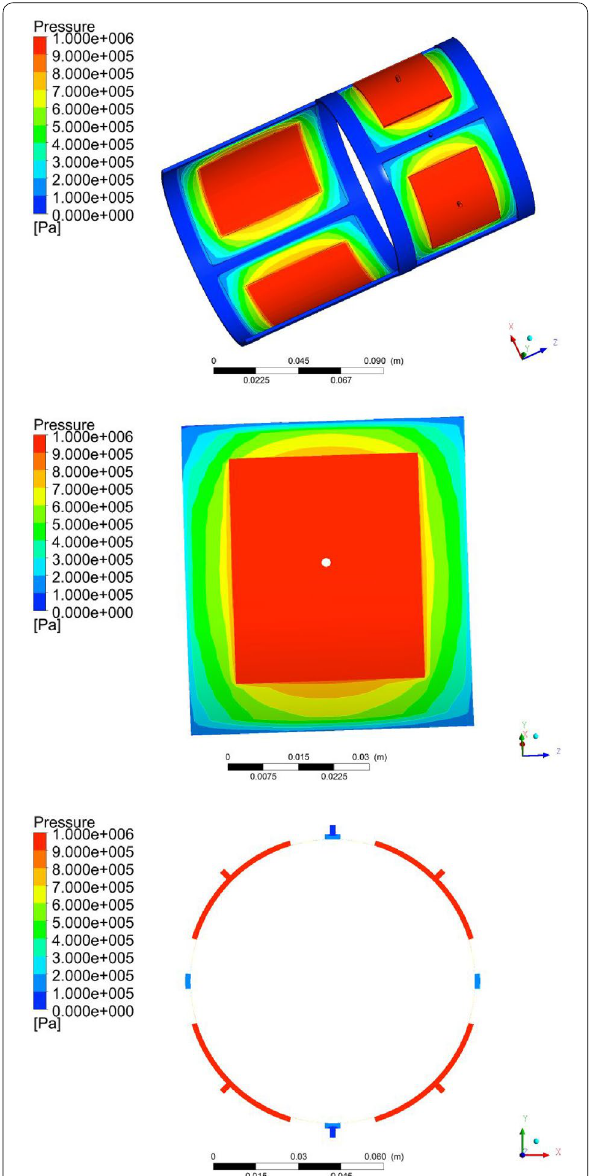
comparison analysis. Figure 16 presents a position-pres- sure diagram of the inner-wall surfaces of the oil cham- bers and Figure 17 presents a position-pressure diagram of the central sections of the oil chambers with the z -axis as the normal. In Figure 16, the ranges of 30–90 mm and 120–160 mm represent the positions of the inner wall surfaces of the oil chambers of the oil pads. The black dots indicate the oil chamber pressure without a par- tial load with a value of approximately 953275 Pa. The red dots indicate the pressure in the oil chamber with a